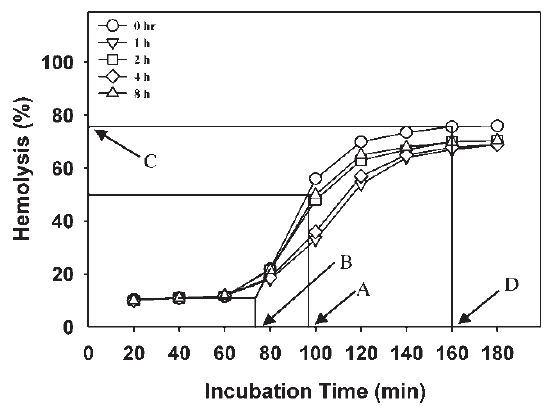
Figure 2. Time-dependent hemolysis of erythrocytes from one subject at baseline, and 1, 2, 4 and 8h after receiving 0.25g/kg BW of a cocoa beverage. The reaction was induced by 200mM AAPH. Arrows indicate the parameters that were calculated: (A) 50% hemolysis; (B) lag time; (C) maximal hemolysis; (D) time at which maximum hemolysis is